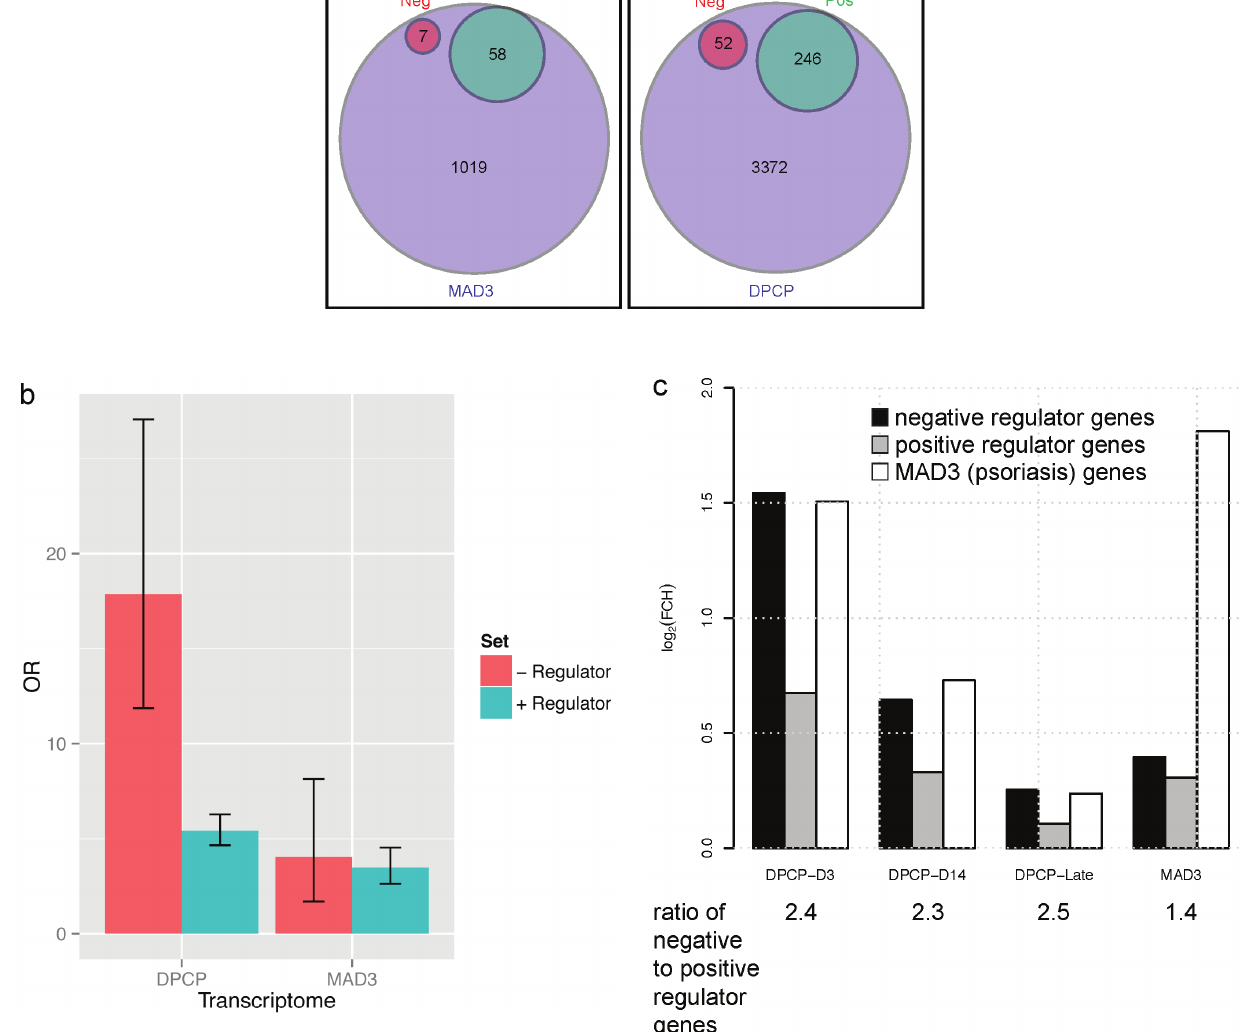
Figure 1. Psoriasis lesional skin has an altered global balance of positive vs. negative regulatory gene transcripts compared to DPCP reactions. ( a ) Venn diagrams showing overlap of MAD3 psoriasis transcriptome (left) and DPCP day 3 transcriptome (right) with both positive regulatory (Pos) and negative regulatory (Neg) gene lists (common gene lists applied to both transcriptomes). The percentages of the MAD3 and DPCP day 3 transcriptomes comprised of the positive regulatory gene list are 5.7% and 7.3%, respectively. On the other hand, the percentages comprised of the negative regulatory gene list are 0.7% and 1.5%, respectively. ( b ) Odds ratios (OR) of negative regulatory (red bars) and positive regulatory (blue bars) gene lists in DPCP day 3 and psoriasis transcriptomes. ( c ) Black bars represent negative regulator genes, gray bars represent positive regulator genes, and white bars represent all MAD3 psoriasis transcriptome genes. The y-axis shows log (fold change) of all genes in the given gene set. DPCP day 3 and MAD3 samples have comparable MAD3 transcriptome expression 2 levels but there is a substantial difference between all DPCP time points (days 3, 14, and 120 or “late”) and MAD3 samples in terms of the relative levels of negative and positive regulator gene list expression. This is quantified as the “ratio of negative to positive regulator